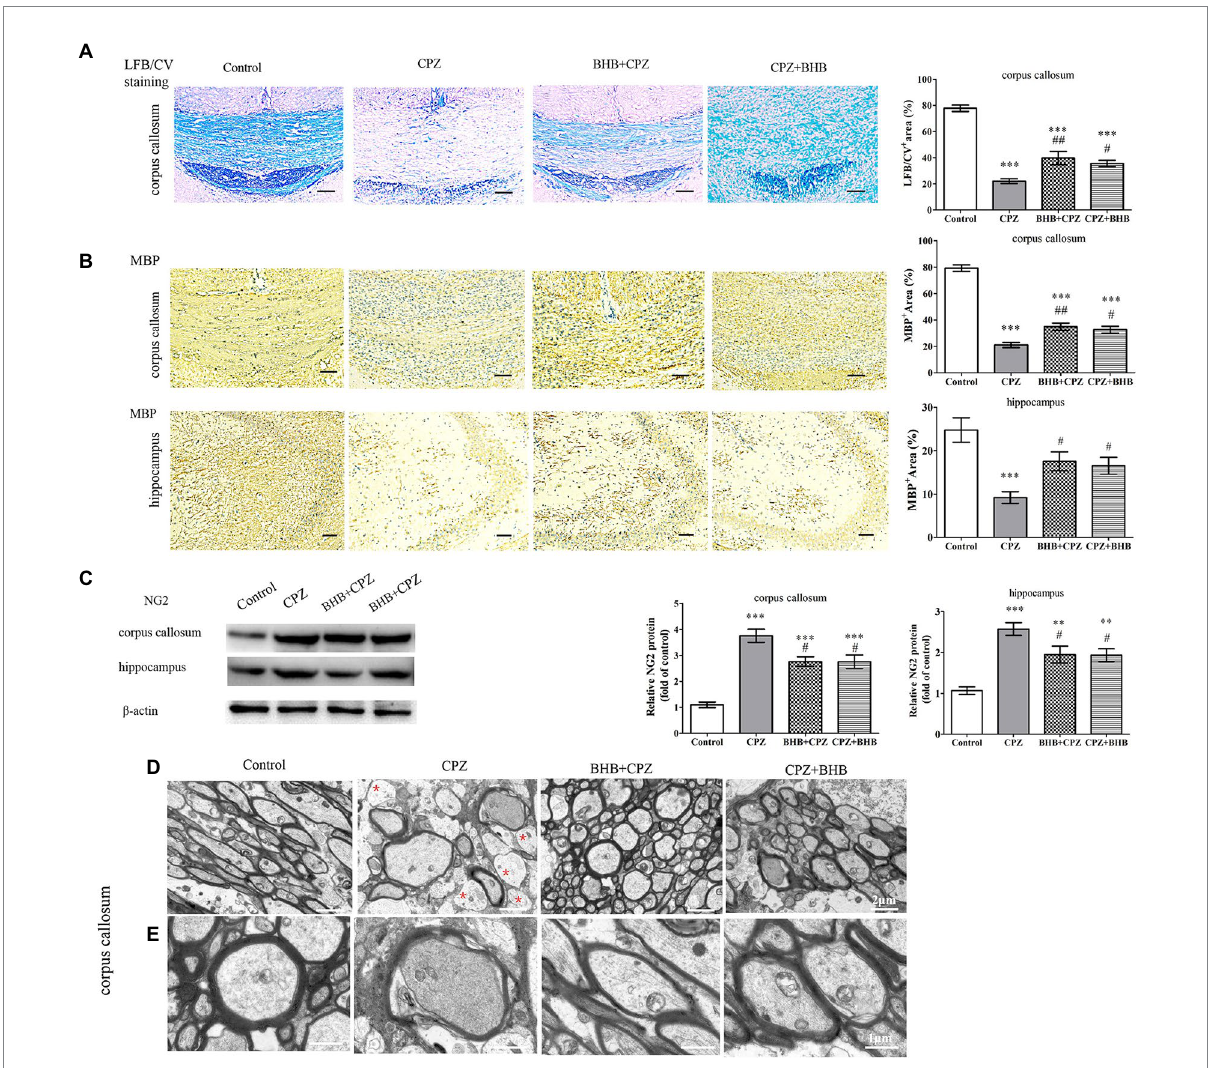
FIGURE 5 BHB treatment reduced demyelination in CPZ-fed mice. (A) Histological evaluation of demyelination by LFB/CV staining. Scale bars = 50 μ m. (B) Representative MBP staining and intensity quantification in the corpus callosum and hippocampus of CPZ-fed mice among different groups. Scale bars = 50 μ m. (C) Western blot analysis of NG2 expression in CPZ-fed mice. (D and E) Representative TEM images of demyelination in the corpus callosum of CPZ-fed mice. Note that non-myelinated axons (red asterisks) are frequent in CPZ-fed mice; D magnified 4,000×, scale bars = 2 μ m. E magnified 10,000×, scale bars = 1 μ m. Data are presented as mean ± SEM. N = 3 per experimental group; experiment repeated two times. ** p < 0.01 and *** p < 0.001 versus the control group; # p < 0.05 and ## p < 0.01 versus the CPZ